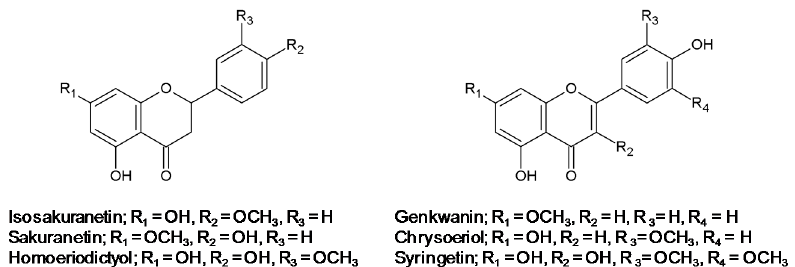
Figure 1. Structure of methoxyflavonoids examined in this study.